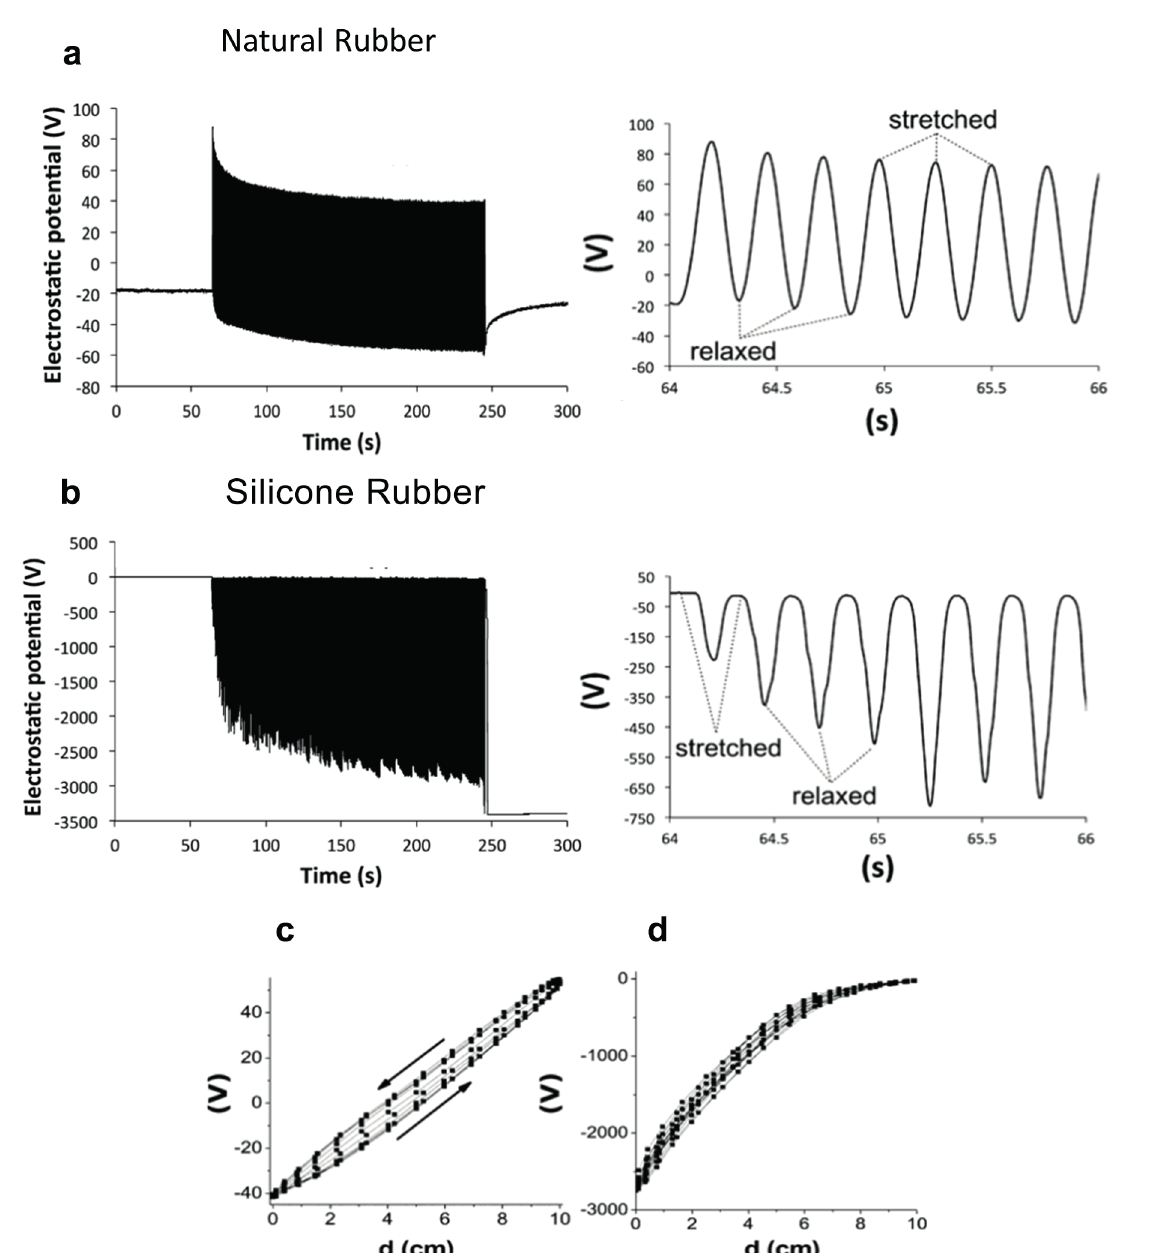
Figure 7 - electrostatic potential of ( a ) natural and ( b ) silicone rubber under stretching−relaxation cycles. A Kelvin electrode recorded the initial electrostatic potential, for 60 s. The stretching−relaxation cycles followed for 180 s and then ceased, leaving the material at the starting position. Zooms from ( a,b ) are shown in the inset graphs. ( c,d ) voltage vs distance for natural and silicone rubber, respectively. experiments were performed at 60% Rh. Reprinted (adapted) with permission from (Burgo et al. 2017). Copyright 2017 American Chemical